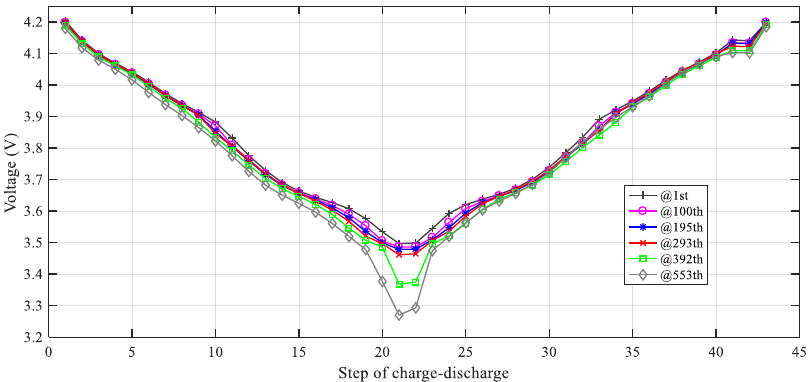
Figure 4. Open circuit voltage (OCV) test data.